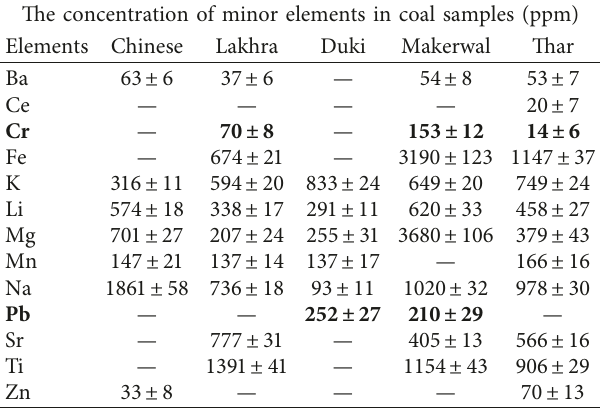
Table 3: Quantitative analysis of minor elements in coal samples collected from coal mining sites across Pakistan and one Chinese coal sample. The concentration of minor elements in coal samples (ppm) Elements Chinese